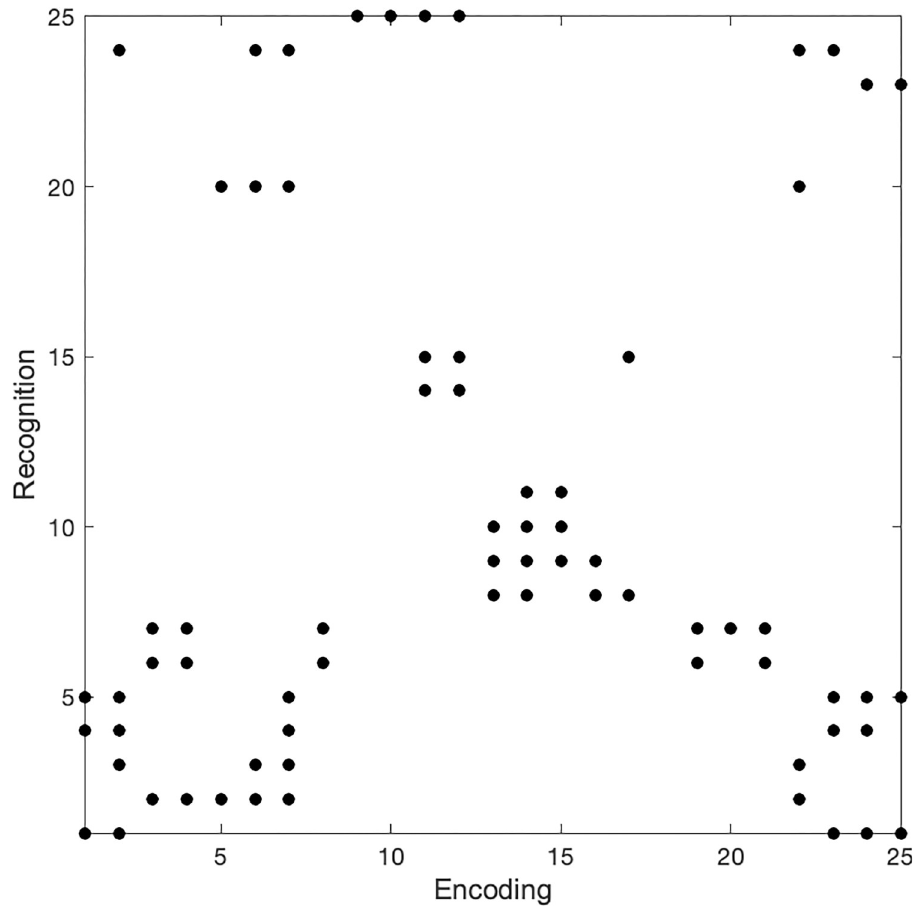
Fig 5. Example of a cross-recurrence diagram. The encoding and recognition fixations are adjusted to 25 fixations, with dots indicating cross-recurrences. For example, encoding fixation 3 and recognition fixations 2, and 6–7, are cross-recurrent, i.e., their angular distance is below the defined recurrence